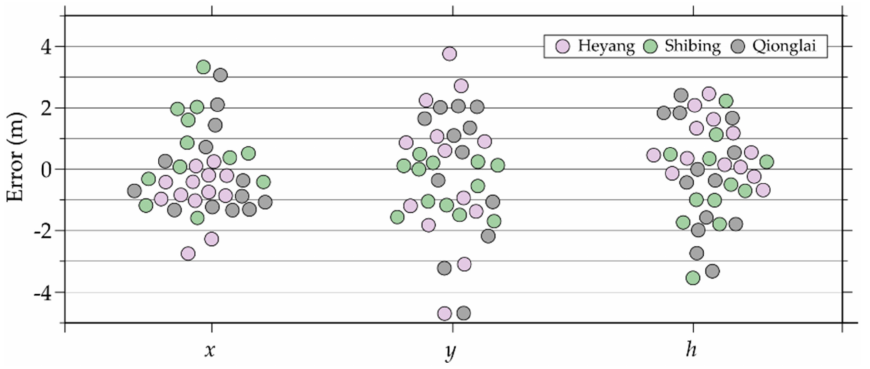
Figure 17. Error distribution of the x , y , and h directions in the Heyang experimental area in Shaanxi, Shibing experimental area in Guizhou, and Qionglai experimental area in Sichuan.